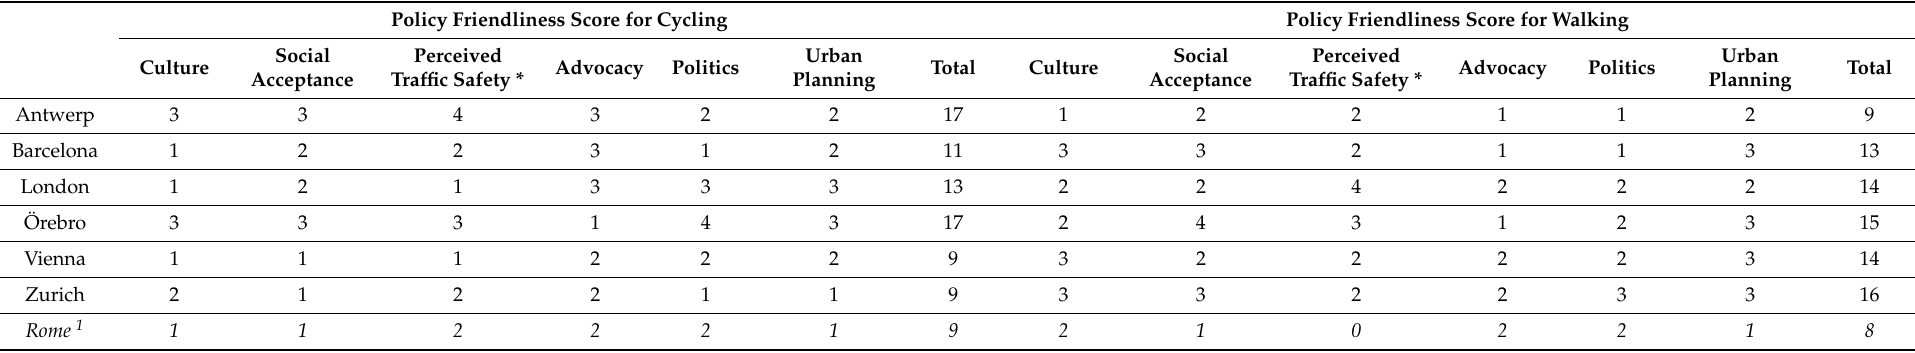
Table 2. Results of the policy friendliness scoring for cycling and for walking, per city, as rated by two independent PASTA experts in 2017, and based on PASTA baseline survey data for the scoring item “perceived traffic safety”. Each item was scored on a scale of 0 (not existing, no evidence of recognition or reflection) to 4 (very much existing, great reflection and recognition, we could not wish for much